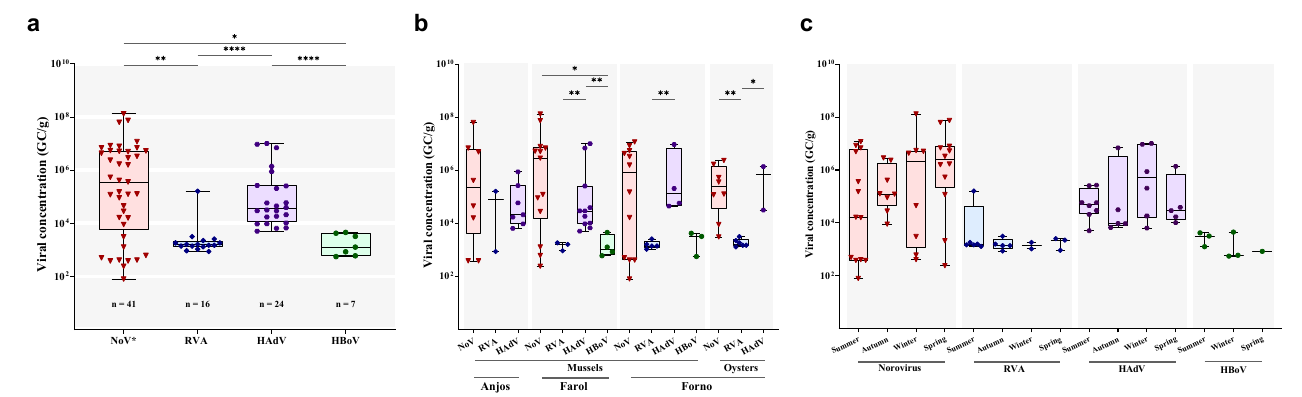
Figure 2. ( a ) Overall variation of enteric viruses’ concentration in bivalve samples and the viral load of enteric viruses by ( b ) sampling site and ( c ) season. Box and whisker plots show the first and third quartiles (equivalent to the 5th and 95th percentiles), the median (horizontal line in the box) and range concentrations [genome copies per gram (GC/g) of digestive tissue]. * p ≤ 0.05; ** p ≤ 0.01; **** p ≤